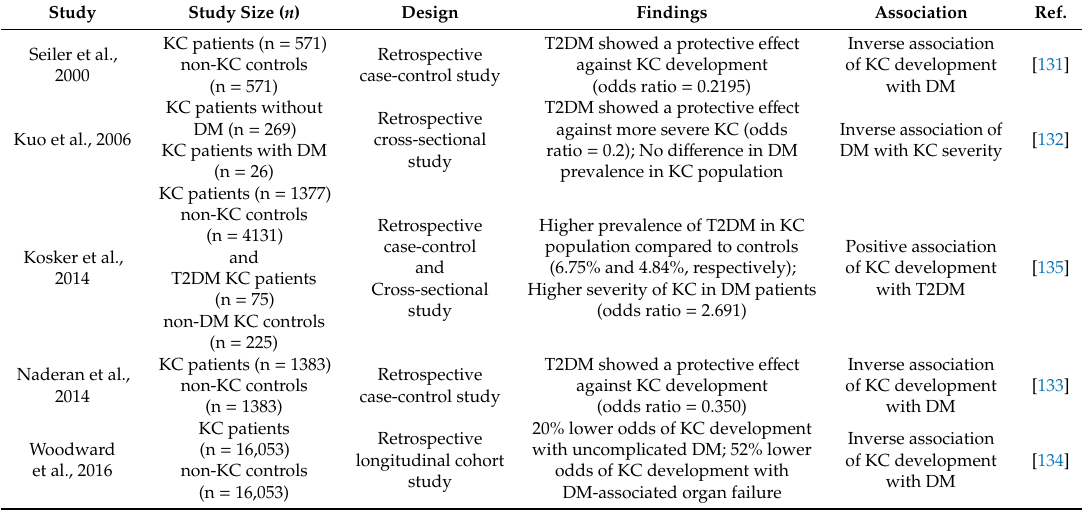
Table 3. Summary of epidemiological studies comparing DM and KC prevalence in human